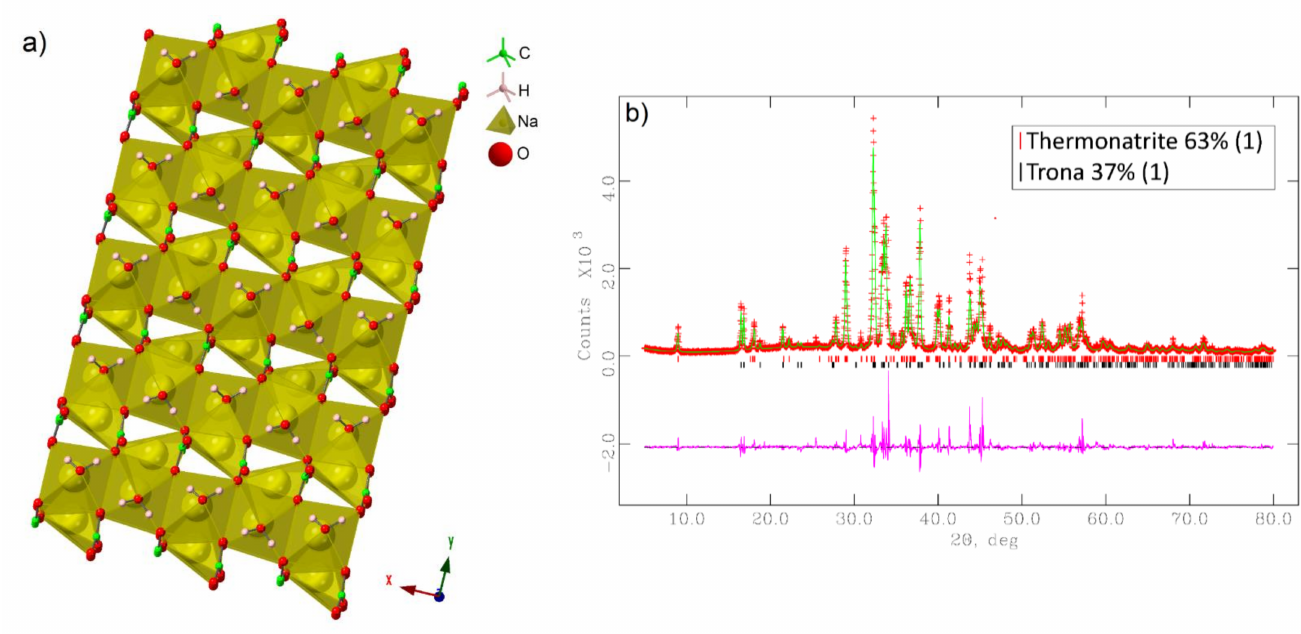
Figure 7. ( a ) Crystal structure of thermonatrite projected along the z-axis [75]. The sticks represent the C . . . O bonds and OH . . . O hydrogen bonds. ( b ) X-ray diffraction profile of the sample define as thermonatrite collected at room temperature and refined by the Rietveld method [60] with Rp.